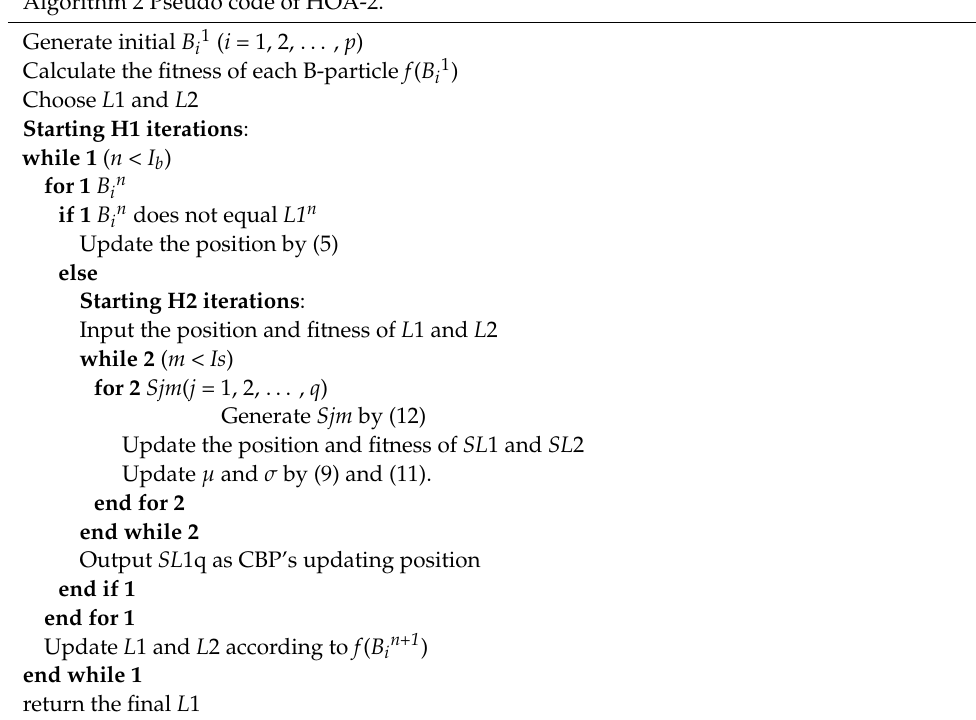
Algorithm 2 Pseudo code of